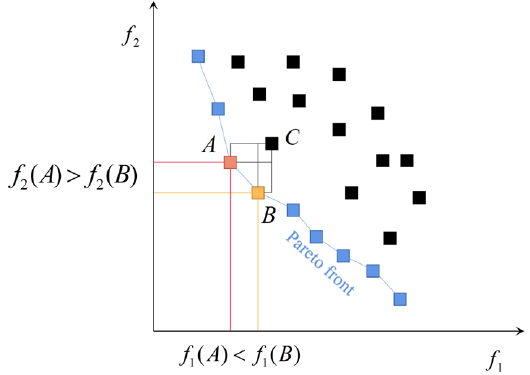
Figure 6. Dominance relationships among individuals.